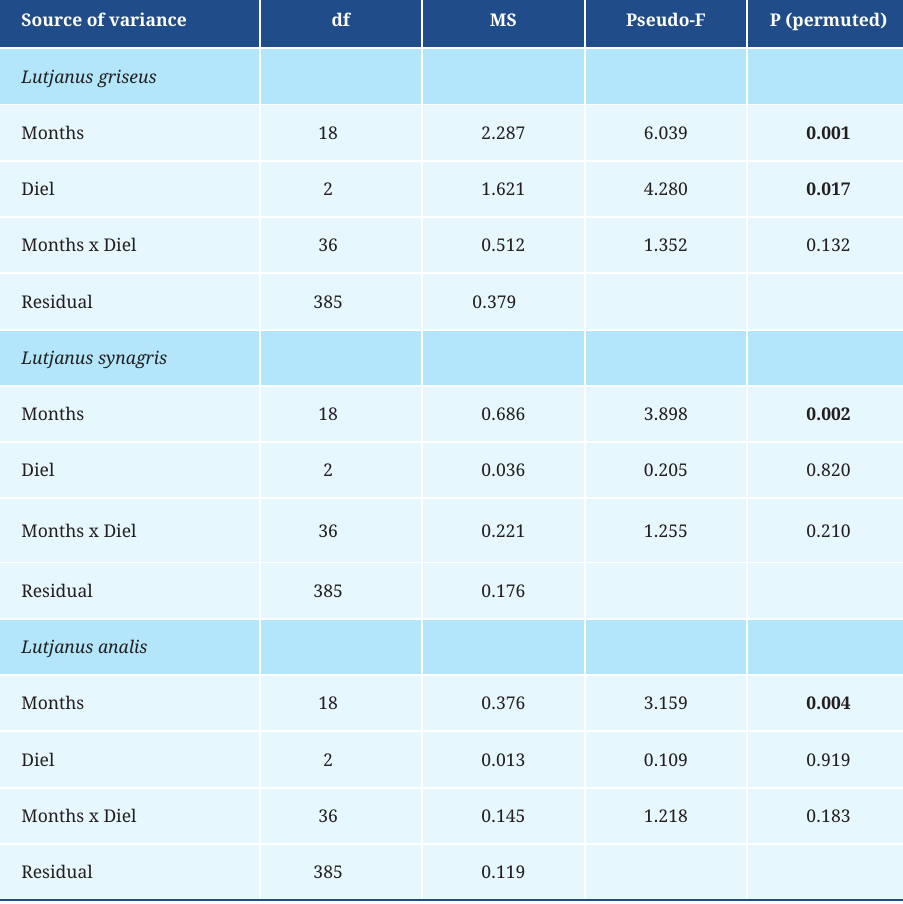
Source of variance df MS Pseudo-F P (permuted)